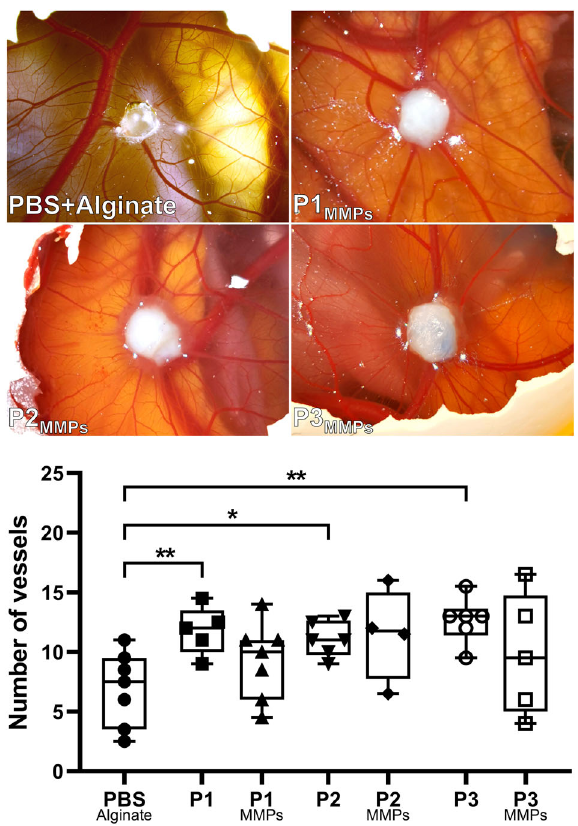
Fig. 4 The chorioallantioc membrane (CAM) bioactivity assay con fi rmed a signi fi cant increase in angiogenesis after the inoculation of the three scaffold types before the matrix metalloproteinase 2 and 9 (MMPs) preconditioning compared with the inert alginate reference point that indicate normal chick fetal angiogenesis. The bioactivity from the scaffolds stimulated a doubling of blood vessel formation, while there was a modest (non- signi fi cant) reduction in angiogenic effects after the MMPs treat- ment. Graphs show box plot with each sample value, median ± IQR, and range. P protocol. Signi fi cant levels; * p < 0.05; ** p <